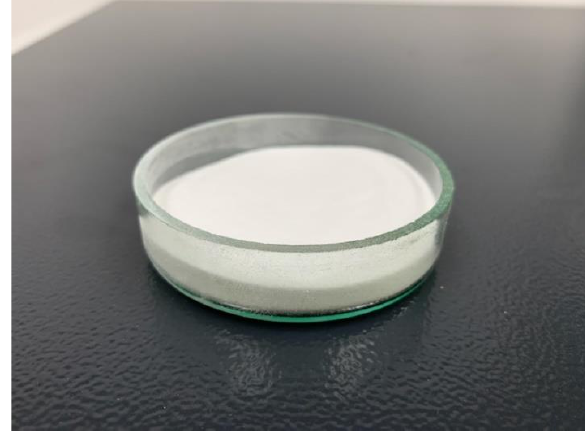
Figure 2. EVA redispersible polymer powder. Table 3. Chemical composition of the EVA polymer [24].